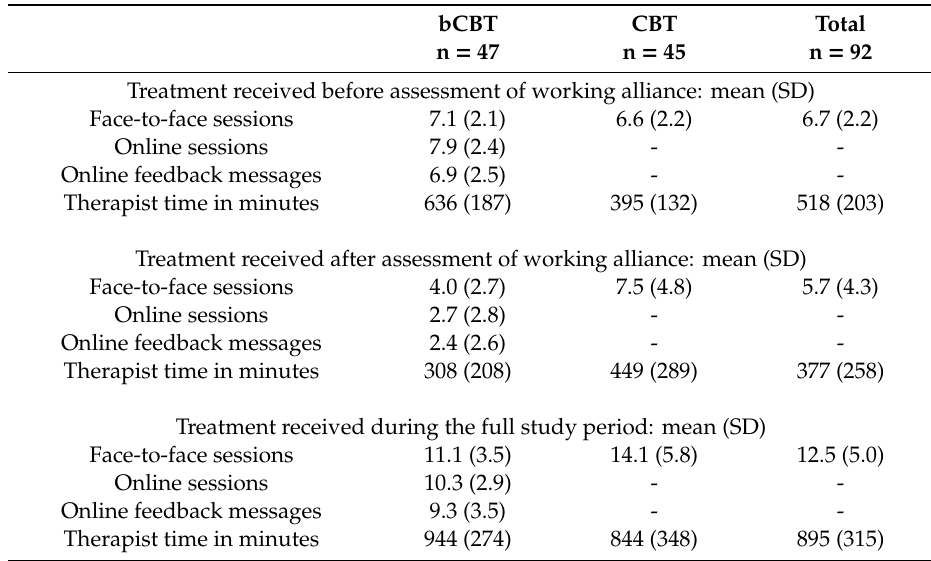
Table 2. Treatment received in the two study groups.